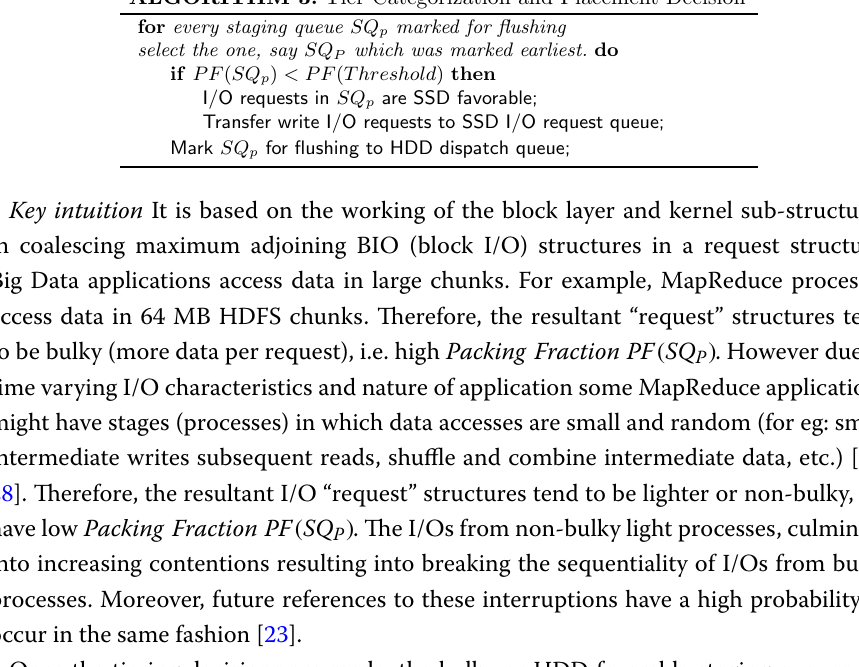
ALGORITHM 3: Tier Categorization and Placement